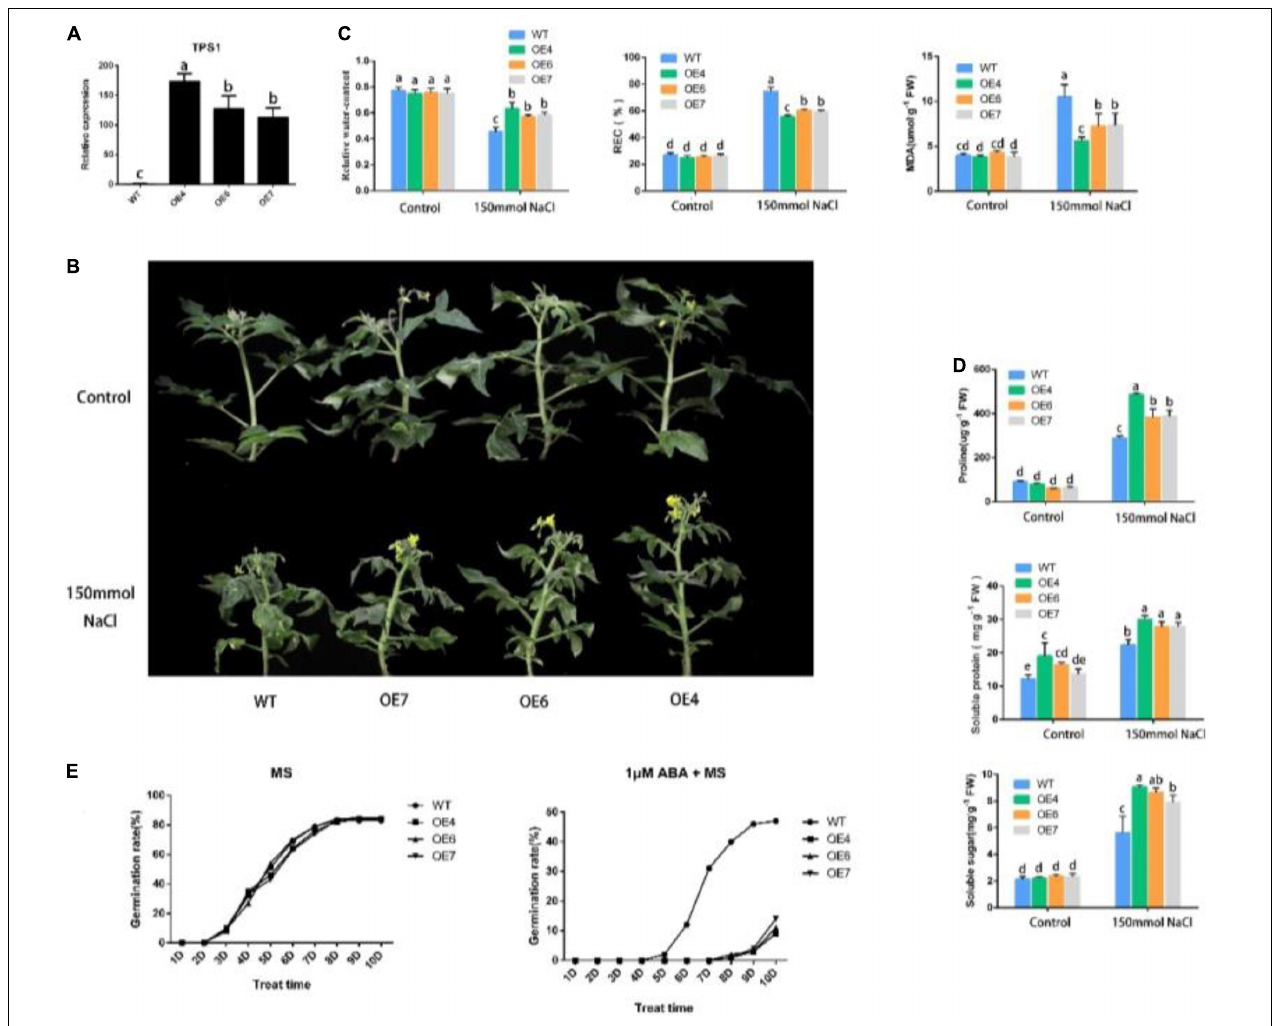
FIGURE 2 | Functional identification of PpTPS1 . (A) qRT-PCR analysis of PpTPS1 transgenic tomato lines under normal condition. Transgenic tomato lines under normal condition. (B) Growth status of WT and transgenic tomatoes treated with NaCl for 12 days. (B,C) The leaves of WT and transgenic tomatoes treated with NaCl for 12 days were taken to measure the relative electrical, and MDA contents Growth status of WT and transgenic tomatoes treated with NaCl for 12 days. (C) Analysis of the relative electrical measurement and MDA content and relative water content of WT and transgenic tomatoes treated with NaCl for 12